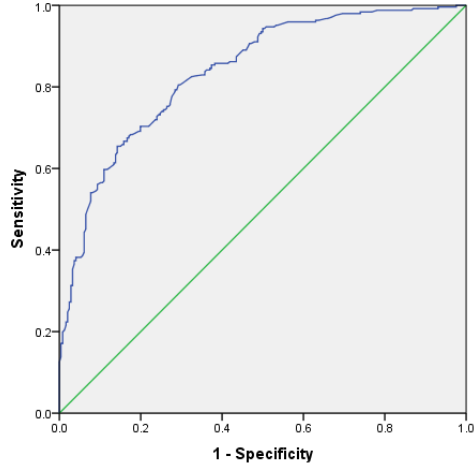
Figure 1. The area under the receiver operating characteristic (ROC) curve (AUC) for the prediction of tuberculosis in type 2 diabetes mellitus for the total sample.